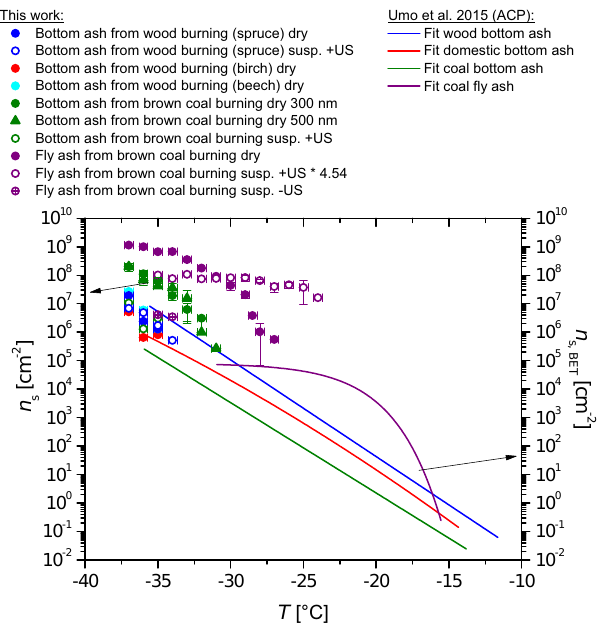
Figure 5. Comparison of ice nucleation surface site density n s as a function of temperature T for ash particles from dry (full circles: 300nm particles, triangles: 500nm particles) and wet generation (open circles: 300nm particles) with results by Umo et al. (2015, lines). For the LACIS measurements, the particle surface area was determined assuming spherical particles (left ordinate), whereas the n s values reported by Umo et al. (2015) are based on the BET spe- cific surface area of the particles (right